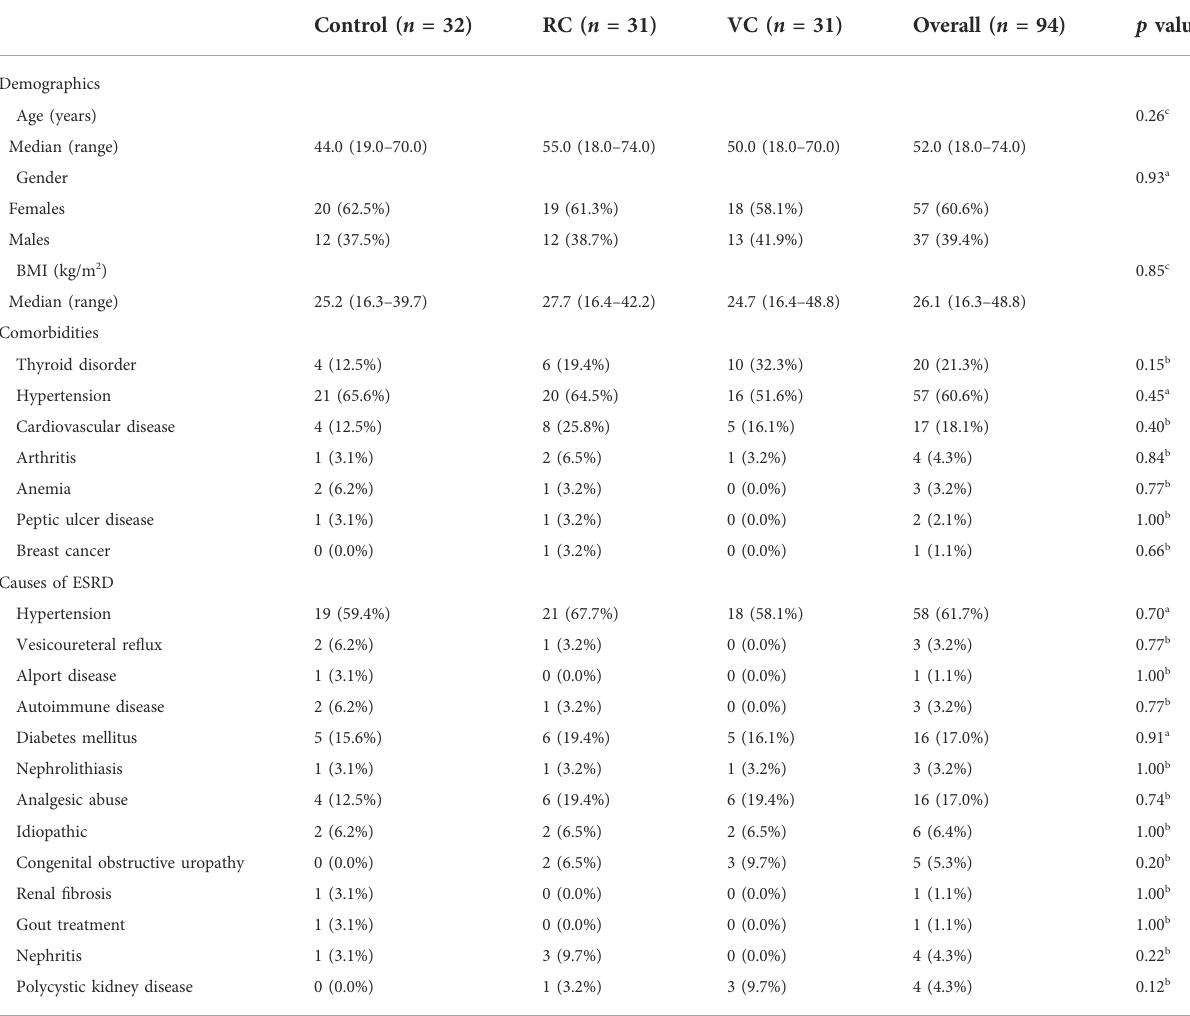
TABLE 1 Baseline demographic data and clinical characteristics of the studied